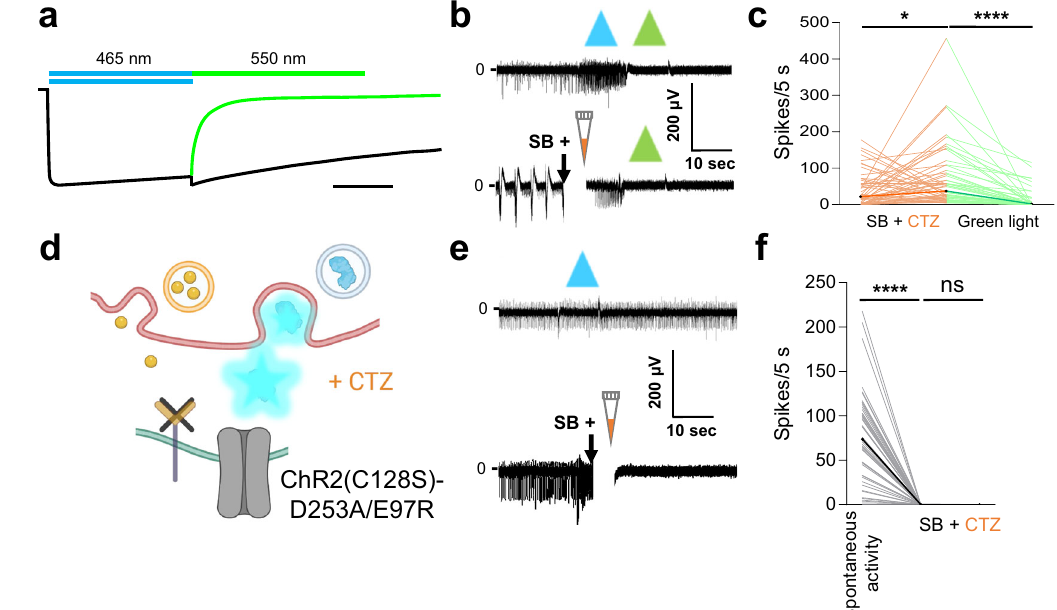
Fig. 6 Interluminescence is mediated by bioluminescence activation of the opsin. a Schematic showing the typical photocurrent of the step-function opsin ChR2(C128S) with a pulse of blue (465 nm) light (black trace under blue bar). There is prolonged depolarization after the light stimulation ends (continuation of black trace). Exposure to green (550 nm) light terminates the depolarization and returns the channel to its closed state (green trace under green bar; adapted from ref. 15 , Fig. 2a; scale bar indicates 10 s). b Representative traces of MEA recordings of postsynaptic ChR2(C128S) expressing neurons from a cortical-striatal co-culture. ChR2(C128S) can be activated by blue light and inactivated by green light (upper trace). In the presence of synaptic blockers (SB) depolarization caused by CTZ is also inactivated by green light (lower trace), indicating that the channelrhodopsin mediates the Interluminescence effect. c Ladder plots depict recordings from electrodes across populations as in (b, lower trace) (SB + CTZ, n = 51, p = 0.0369; Green Light, n = 51, p < 0.0001; Wilcoxon matched-pairs signed rank test). d Schematic of synapse with postsynaptic neuron expressing a non-functional opsin, ChR2(C128S)-D253A/E97R. e Representative traces of MEA recordings of postsynaptic ChR2(C128S)-D253A/E97R expressing neurons from a cortical- striatal co-culture. Postsynaptic neurons expressing the mutant opsin show no responses to either direct blue light stimulation (upper trace) or to CTZ application (lower trace), indicating that Interluminescence is a speci fi c effect through the opsin. f Ladder plots of recordings under the conditions depicted in ( e , lower trace) (Before vs after addition of SB, n = 49, p < 0.0001; Wilcoxon matched-pairs signed rank test; SB alone (after), n = 21, v/s SB + CTZ (after: for non-functional opsin), n = 49, p = 0.7870; Mann – Whitney test). The artifacts due to addition of reagents in MEAs are overlaid by a vertical white bar in the recording traces (the white gap right after addition of SB + CTZ). ns, not signi fi cant; * p < 0.05; **** p < non-functional opsin mutant ChR2(C128S)-E97R-D253A that does not produce photocurrent 20 (Fig. 6d schematic, Fig. 6e upper trace). In cultures expressing inactive ChR2(C128S)-E97R- D253A in postsynaptic neurons, CTZ generated bioluminescence, but no increase in spiking (Fig. 6e, lower trace, Fig. 6f ladder plot; SB alone (after), n = 21, v/s SB + CTZ (after), n = 49, p = 0.7870; Mann – Whitney test; Supplementary Data 6). These data indicate